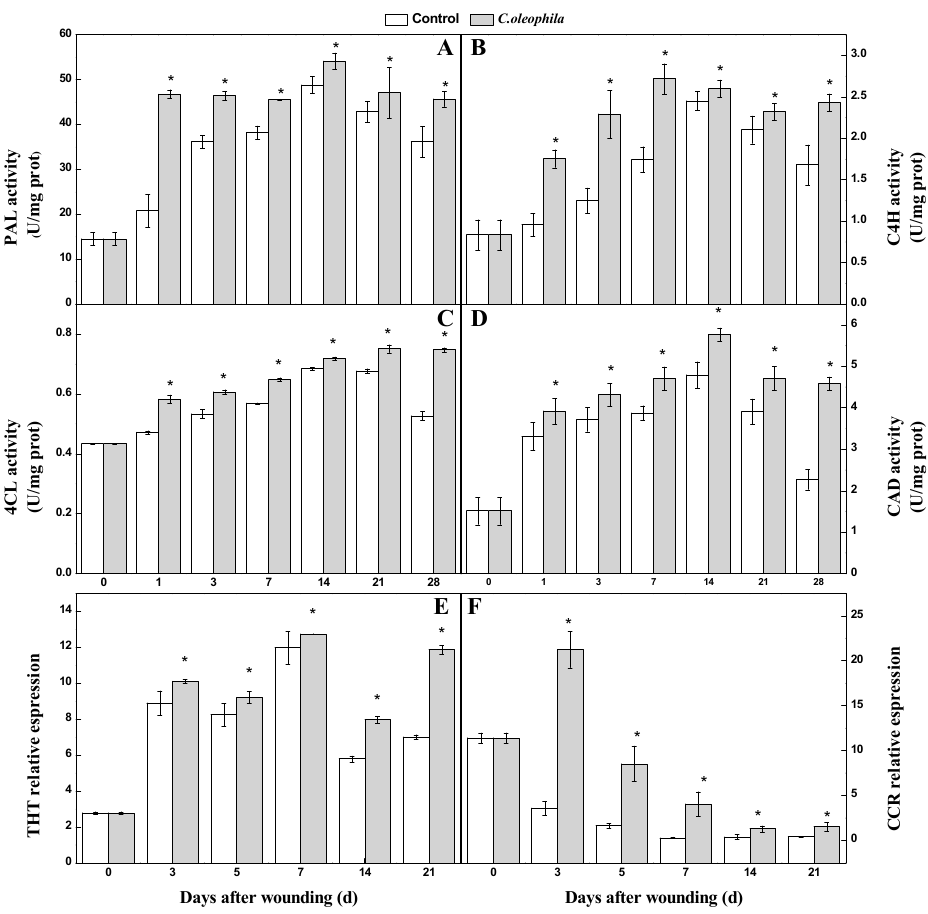
Figure 3. Effects of C. oleophila treatment on the activity of PAL ( A ), C4H ( B ), 4CL ( C ), and CAD ( D ) and THT ( E ) and CCR ( F ) expression at wound sites of tubers during healing. Bars indicate standard error (±SE). Asterisks indicate significant difference ( p < 0.05).